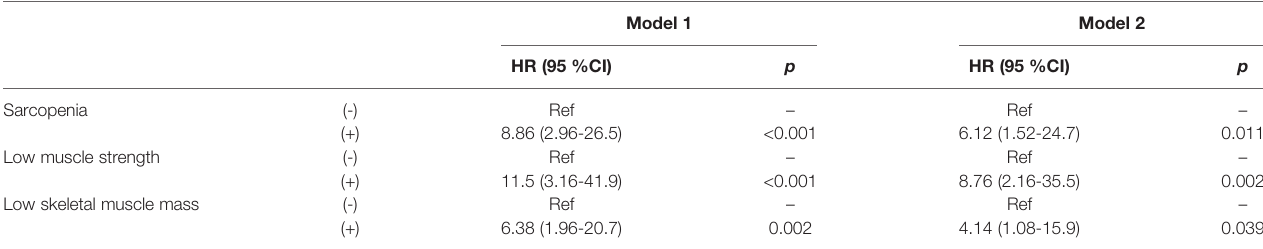
TABLE 3 | Hazard ratio of the presence or absence of sarcopenia, low muscle strength or low skeletal muscle mass for the all-cause